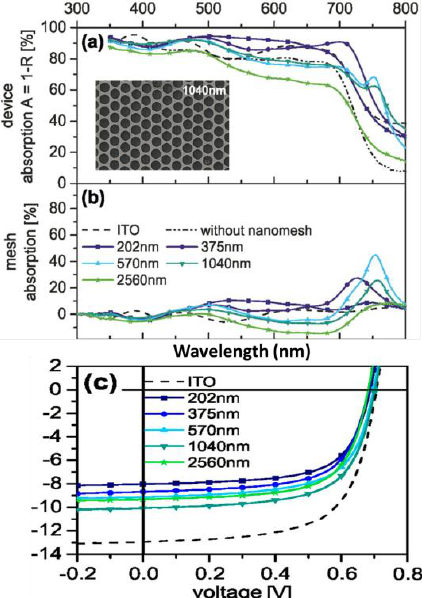
Figure 10. ( a ) Absorption spectra of PTB7:PC 71 BM solar cells with gold nanohole electrodes for different periodicities (solid lines), of the same solar cell without the nanomesh (dash-dotted line), and of the PTB7:PC 71 BM reference device on ITO (dashed line); ( b ) contribution of the nanohole electrode to the device absorption. The nanomesh absorption is obtained by subtracting the absorption (A = 1 − R) of the same solar cell device without a nanomesh electrode (Rblank, dash-dotted line) from the device absorption with nanomesh electrode; ( c ) current-density—Voltage characteristics under illumination of solar cells built on ITO (dashed line) and gold nanohole array transparent conducting electrodes with different periodicities [59]. Reprinted with permission from Ref. [59].